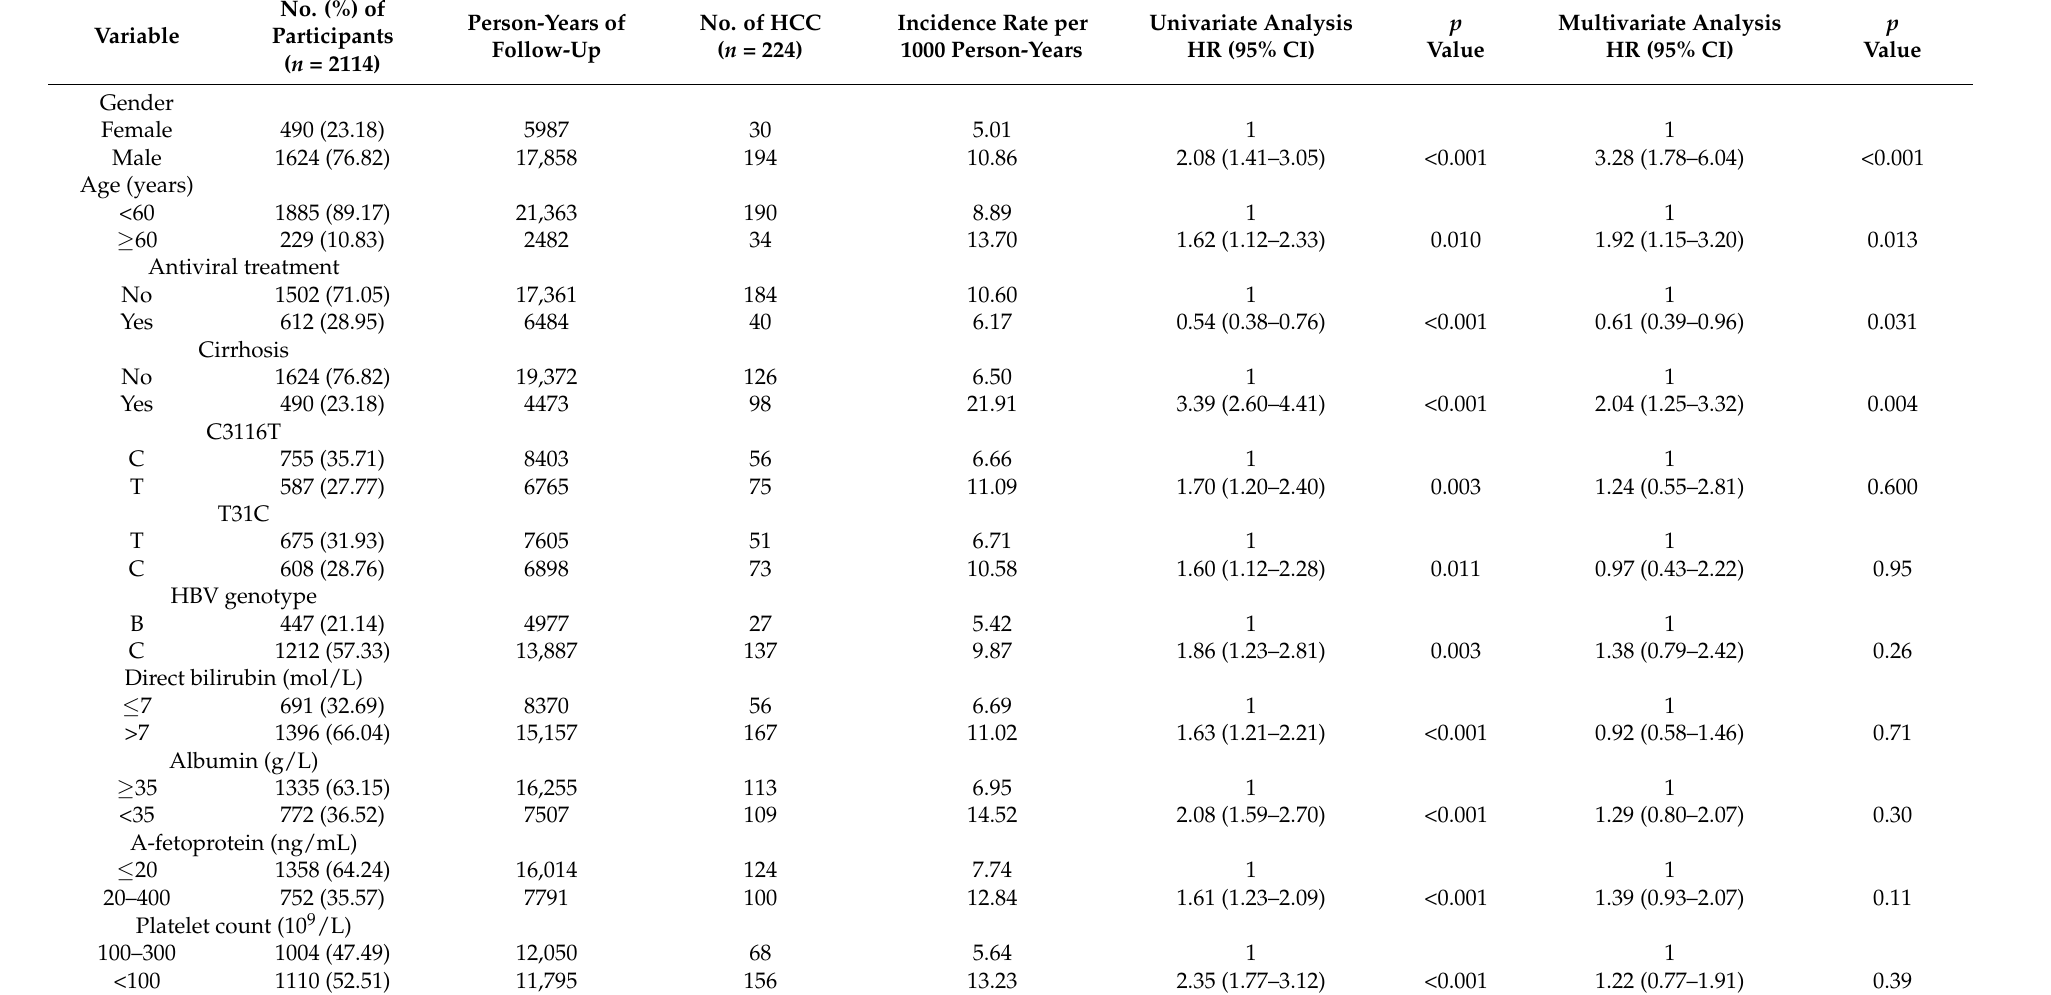
Table 1. Univariate and Multivariate Cox Regression Analysis of Factors Significantly Affected the Occurrence of Hepatocellular